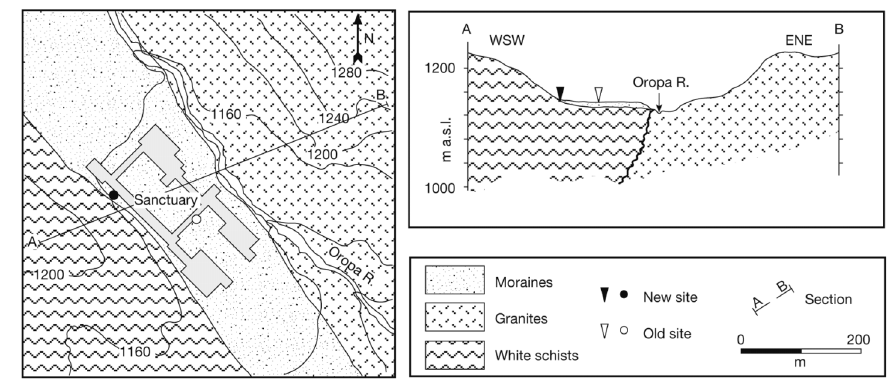
Fig. 9. Geological map and section at the site of the station ORO (Oropa).